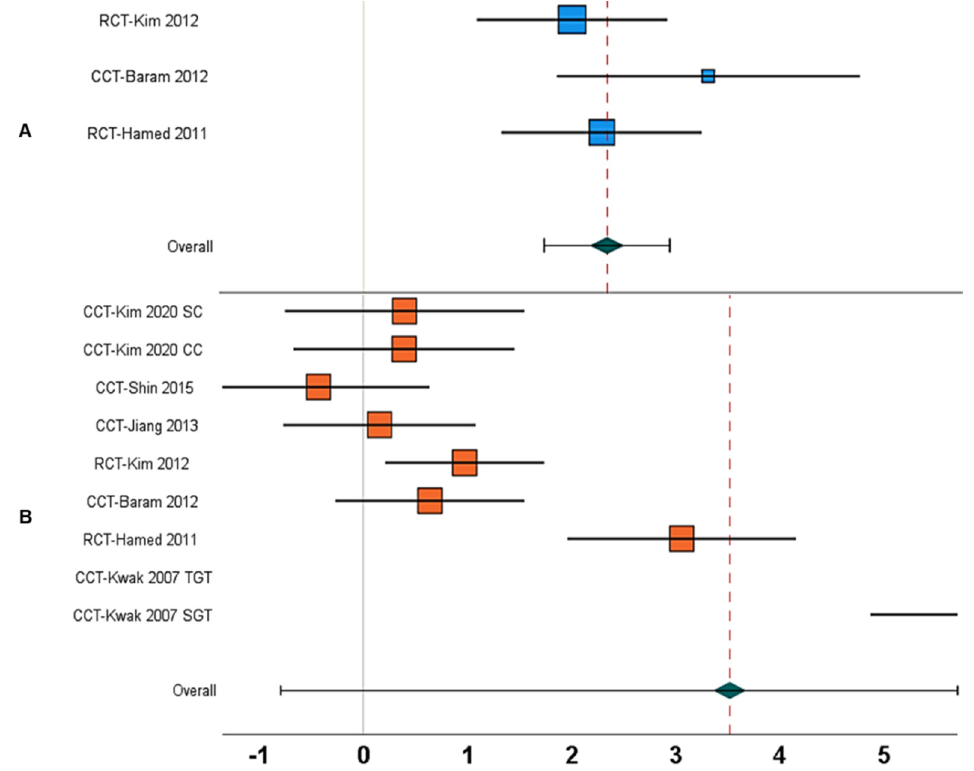
Figure 5. Forest plot illustrating the effect of AStim on stride length in people with cerebral palsy. The forest plots incorporate individual weighted effect size (Hedge’s g), which is represented as boxes (blue: between-group, orange: within-group), whereas the 95% confidence intervals are represented with whiskers. At the bottom, the pooled weighted effect size and 95% CI are represented with a green diamond. ( A ) In this analysis, a positive overall effect size means an enhancement in stride length for the AStim group, whereas a negative overall effect size indicates enhancements in stride length for the control group. ( B ) A positive overall effect size means an enhancement in stride length with AStim, whereas a negative overall effect size indicates reduction in stride length with AStim (RCT: Randomized controlled trial, CCT: Controlled clinical trial, NG: Normal gait, FG: Fast gait, TGT: Therapist-guided training, SGT: Self-guided training).